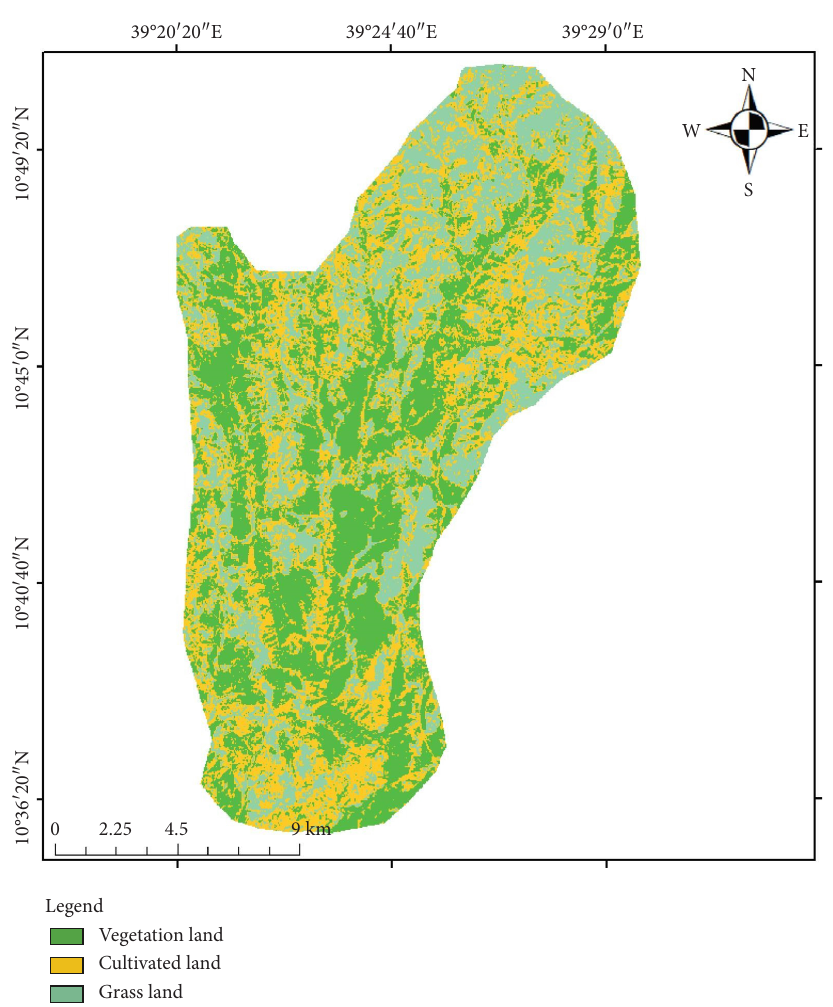
Figure 9: Land use land cover patterns in the Kabe watershed. Table 5: Average soil loss (t ha − 1 yr − 1 ) in the Kabe watershed for diferent land-use